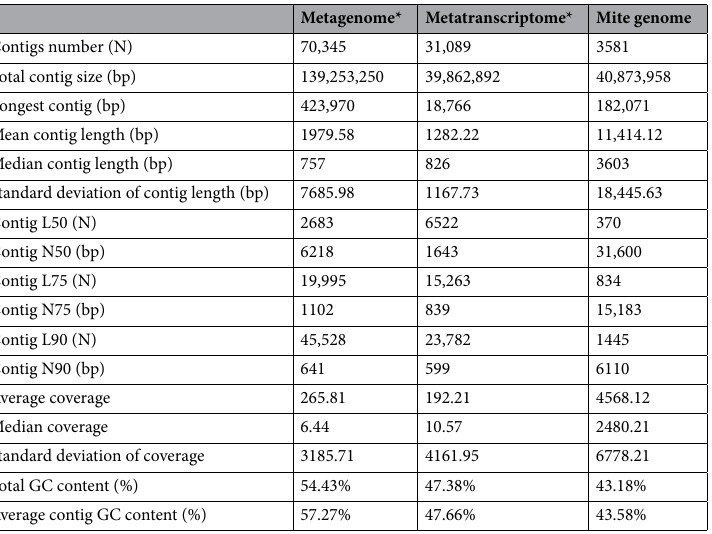
Table 1. Basic statistics for three assemblies of the mite Fragariocoptes setiger and its microbiome. *For contigs ≥ 500 bp